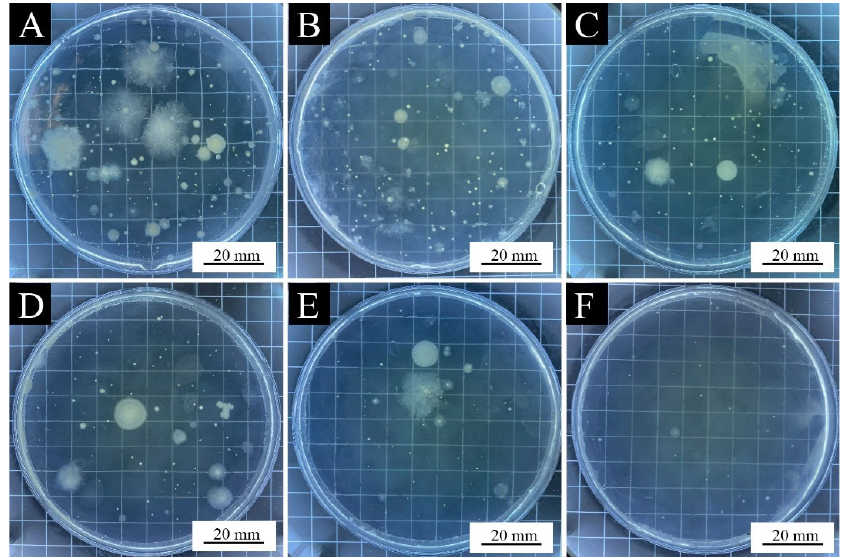
Figure 13. Staphylococcus aureus colonies recovered after antibacterial test of the paint films: ( A ) 0% microcapsule ‐ loaded film, ( B ) 1.0% microcapsule ‐ loaded film, ( C ) 3.0% microcapsule ‐ loaded film, microcapsule-loaded film, ( B ) 1.0% microcapsule-loaded film, ( C ) 3.0% microcapsule-loaded film, ( D ) 6.0% microcapsule ‐ loaded film, ( E ) 9.0% microcapsule ‐ loaded film, and ( F ) 12.0% microcap ‐ ( D ) 6.0% microcapsule-loaded film, ( E ) 9.0% microcapsule-loaded film, and ( F ) 12.0% microcapsule- sule ‐ loaded film. loaded film.